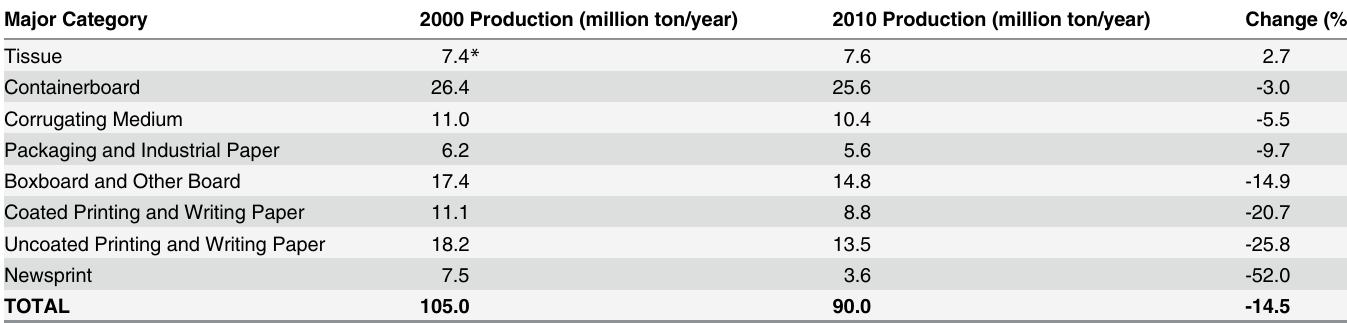
Table 5. Summary of production by major product category.